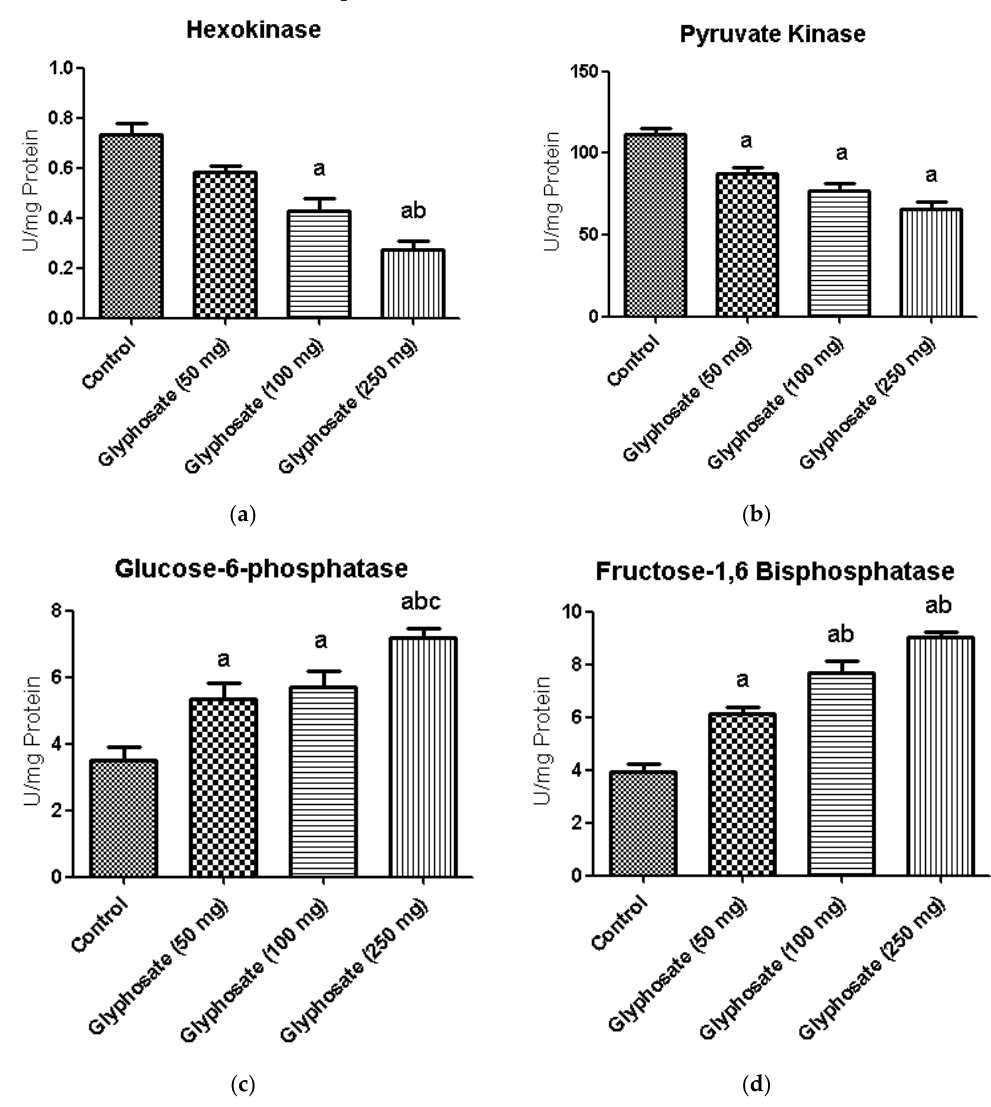
Figure 4. ( a – d ): The effect of glyphosate on the activity of glycolytic (hexokinase and pyruvate kinase) and gluconeogenic (glucose-6-phosphatase and fructose-1,6-bisphosphatase) enzymes in control and glyphosate treated rats. Data were expressed as mean ± SEM where n = 6 rats for each group. Values significant at p < 0.05 were analyzed with a — control, b — glyphosate (50 mg/kg b.wt.), and c — glyphosate (100 mg/kg b.wt.).